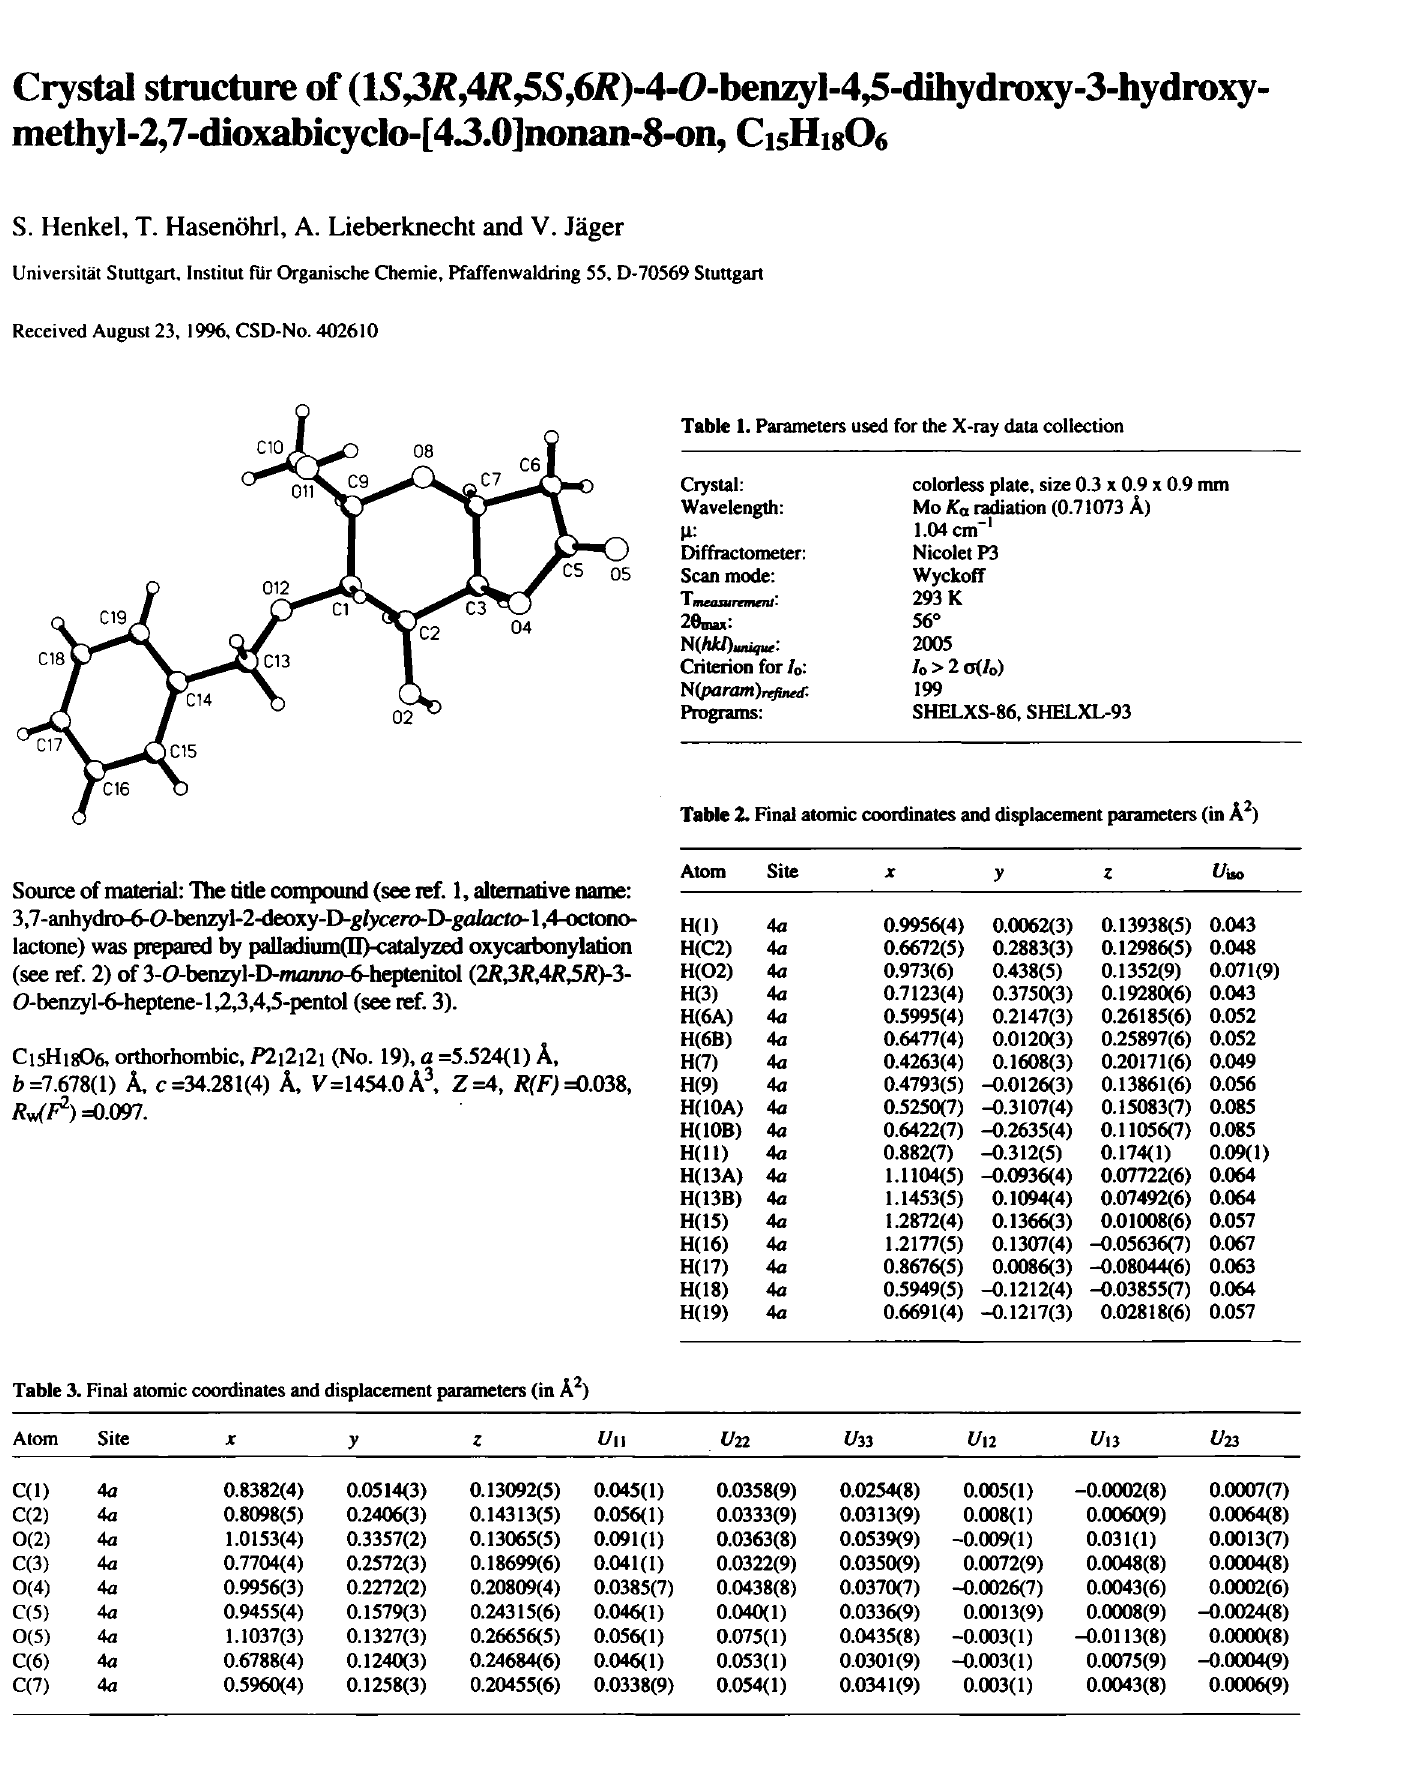
Table 1. Parameters used for the X-ray data collection